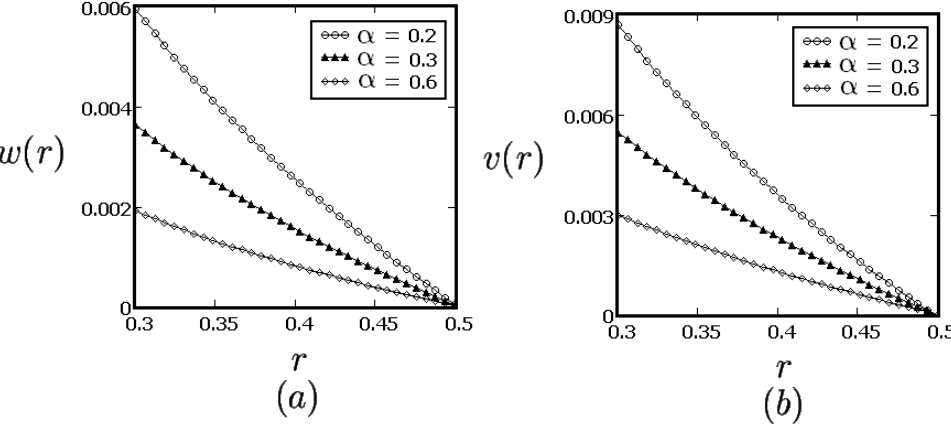
Fig. 6. Profiles of the velocity components w ( r , t ) and v ( r , t ) given by Eqs. (39), for R 1 = 0.3, R 2 = 0.5, f = g = −2, ω 1 = ω 2 = 1, ν = 0.1188, µ = 10.384, t = 8 s and different values of α .